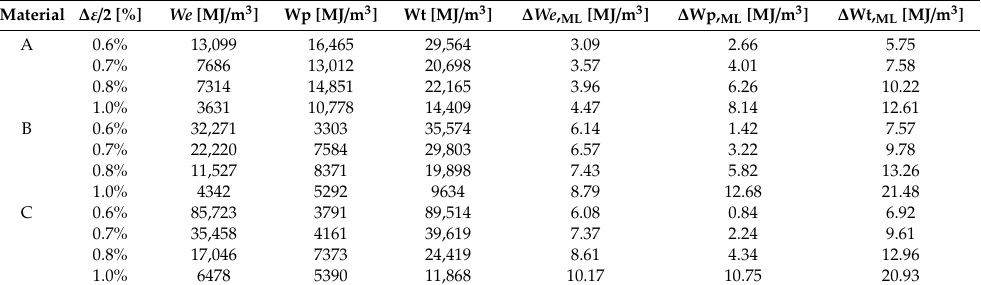
Figure 4. Cumulative plastic (Wp), elastic ( We ) and total (Wt) strain energy density as a function of strain amplitude for: ( a ) steel A; ( b ) steel B; and ( c ) steel C. Table 4. Cumulative strain energy densities at the mid-life cycle of the tested steels.